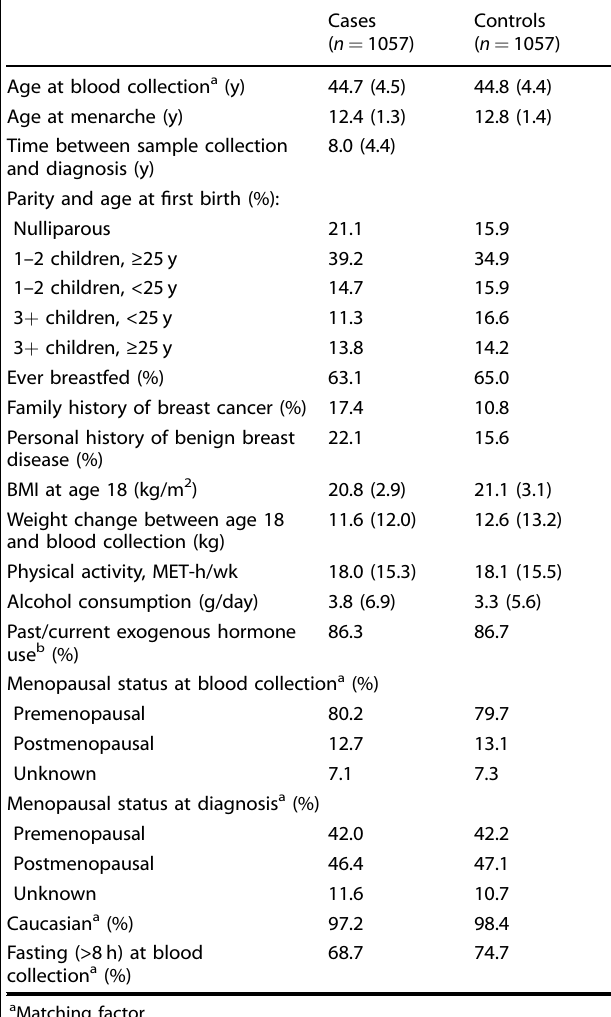
Table 1. Characteristics of breast cancer cases and matched controls at blood collection in the Nurses ’ Health Study II, mean (SD) or